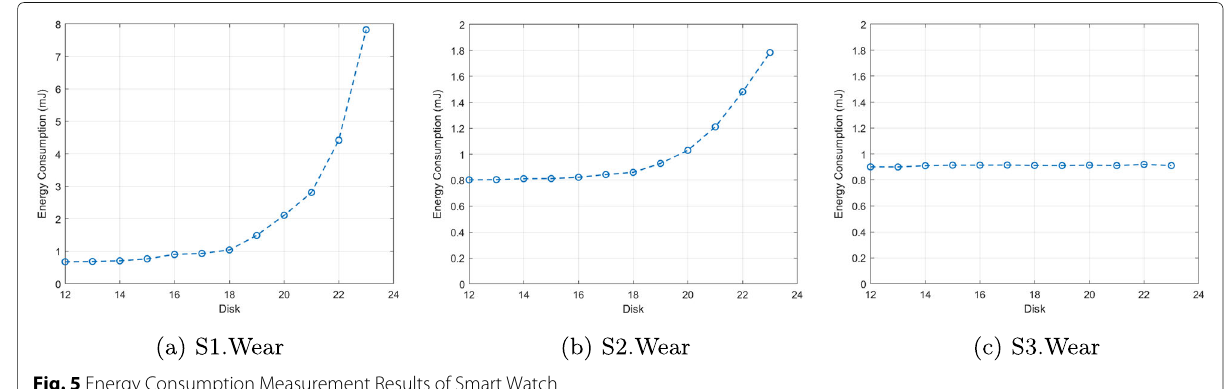
Fig. 5 Energy Consumption Measurement Results of Smart Watch